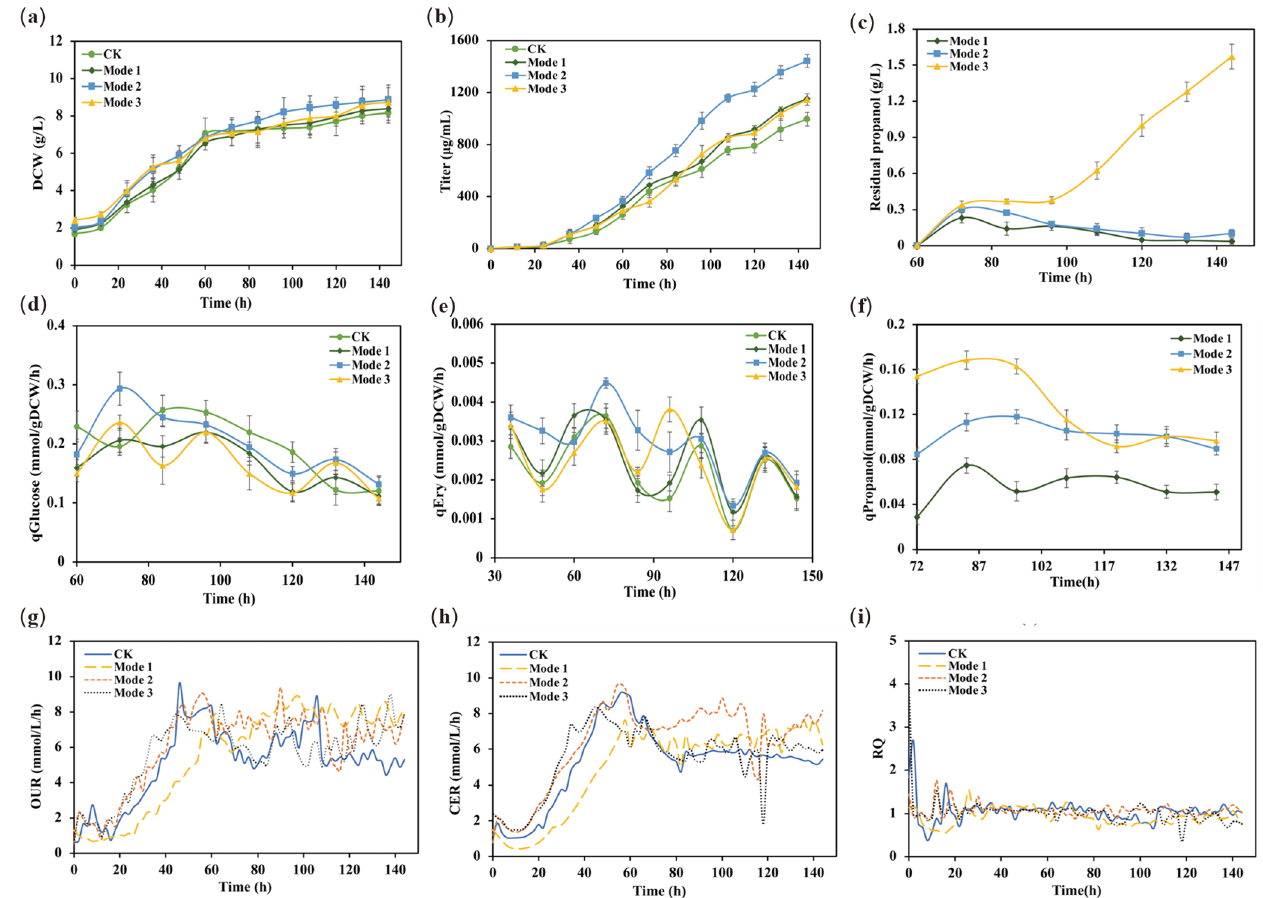
Figure 5. Effects of different n-propanol supplementation on metabolic parameters during the erythromycin fermentation process. ( a ) DCW (g/L); ( b ) titer of erythromycin ( μ g/mL); ( c ) residual propanol concentration (g/L); ( d ) specific glucose uptake rate (mmol/gDCW/h); ( e ) specific erythromycin production rate (mmol/gDCW/h); ( f ) specific propanol consumption rate (mmol/gDCW/h); ( g ) OUR (mmol/L/h); ( h ) CER (mmol/L/h); ( i ) RQ.